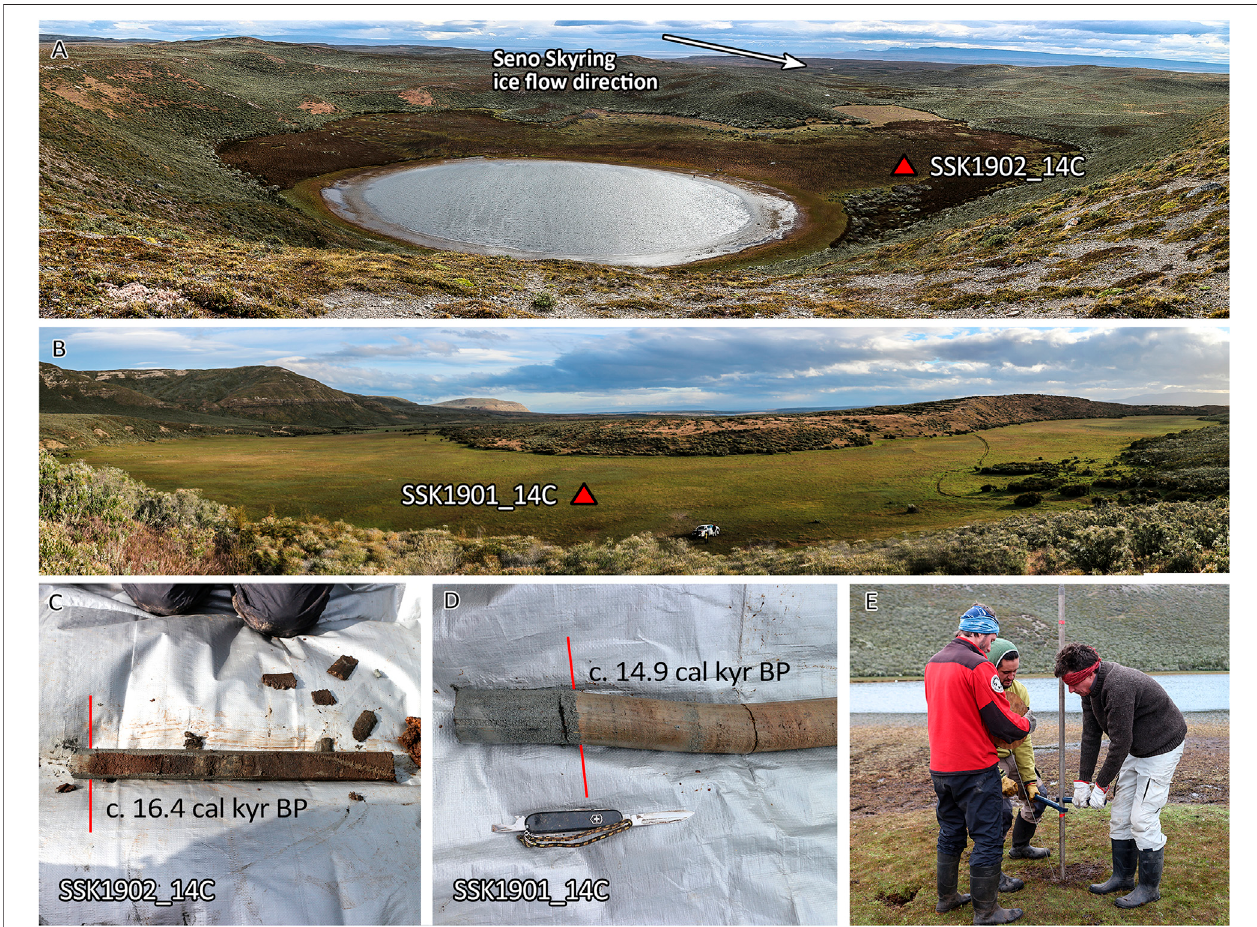
FIGURE10|(A – B) Samplelocationforradiocarbondatinginpeatbogs(redtriangles).In (A) ,thecorewastakenclosetothemarginofalakesittingontheproximal side of the terminal RV moraine. In (B) , the core was taken from an abandoned meltwater channel. (C – D) Core samples from both sites, red lines indicate the contact between organic and inorganic materials, mud and sand sediment, respectively. (E) Wright piston corer being used to sample SSK190214C.